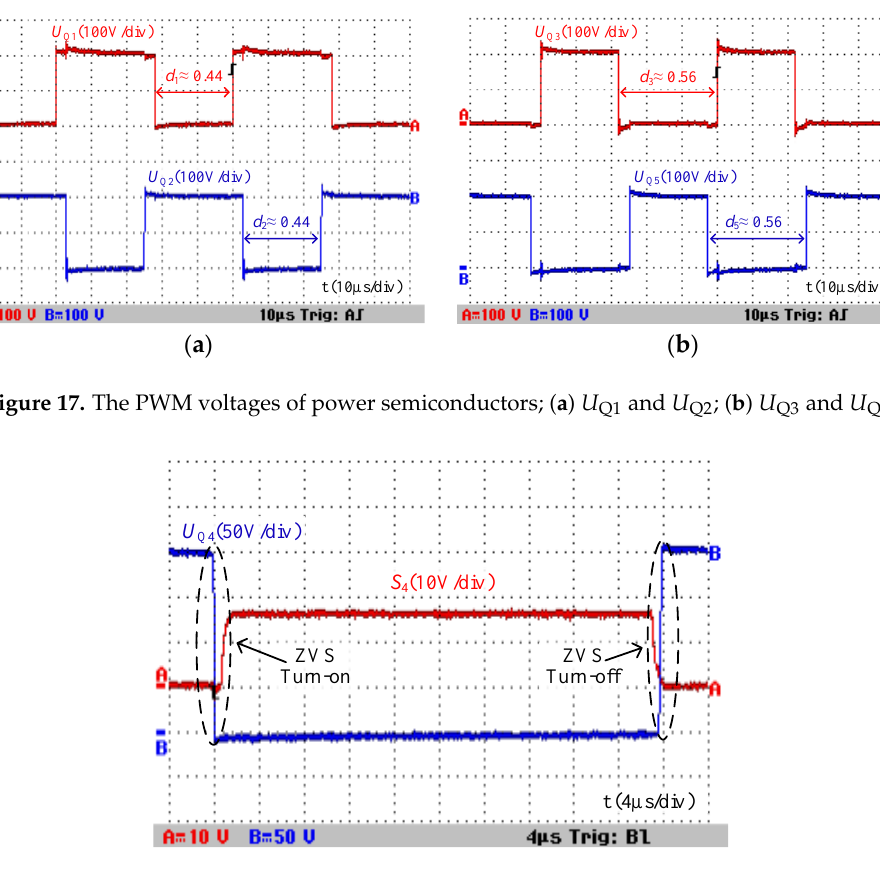
Figure 19. Output voltage and capacitor voltage stress when U high = 200 V. In the step-down mode, the input voltage is U high and the output voltage is U low . The output voltage can also stay around the reference value of 25 V with the action of the voltage control loop. The output/input voltage waveforms shown in Figure 20 can be obtained when changing the input voltage dynamically. According to Figure 20, when the input voltage varies continuously from 200 V to 75 V, the output voltage can stay around 200 V. The conclusion can be obtained from Figure 20 that the proposed converter can obtain a wide voltage conversion ratio from 1/8 to 1/3 in step-down mode. U high (50V/div) U low (10V/div)200V 25V 75V t (1s/div) Figure 20. The output voltage and the wide-range changed input voltage from 200 V to 75 V in step- down mode.